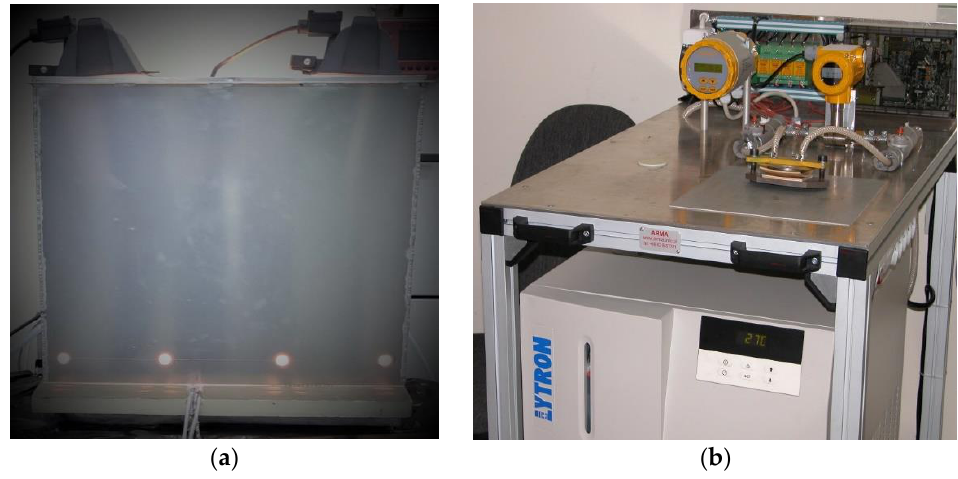
Figure 4. Photos of the setup: ( a ) the dome with mounted lamps; and ( b ) the measuring apparatus.